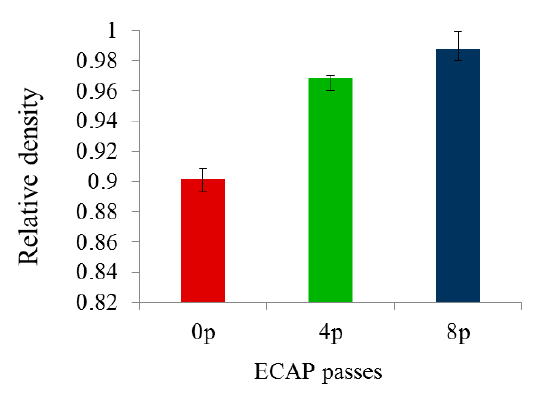
Figure 8. Influence of the ECAP passes on the relative density of SiC p /Al-Si composites. The 0p-ECAP sample corresponds to the PM composite without ECAP processing.